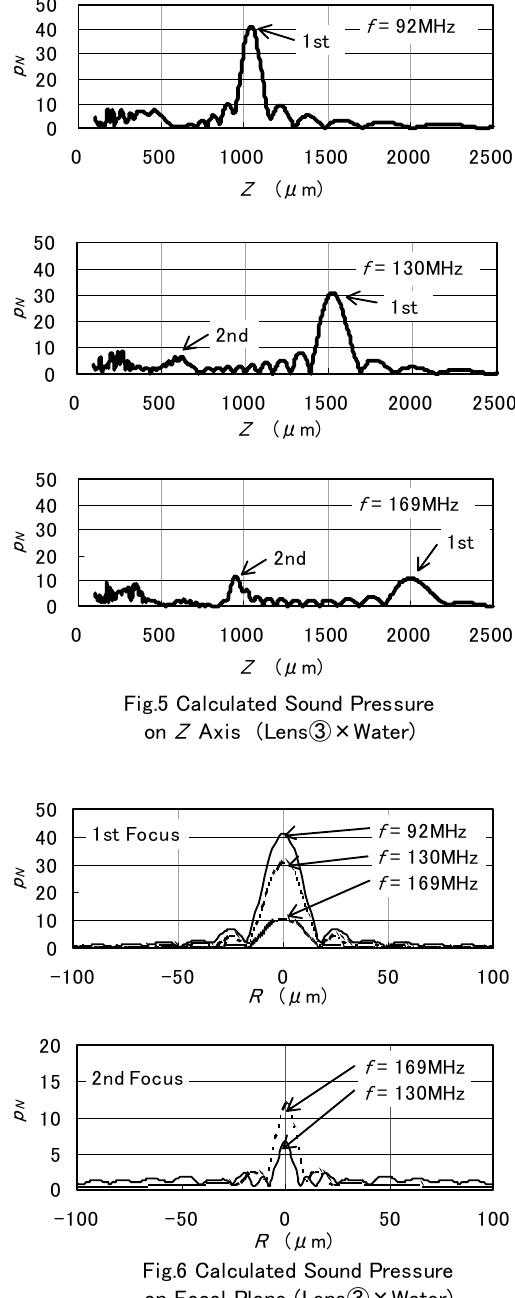
Fig.6 Calculated Sound Pressure on Focal Plane